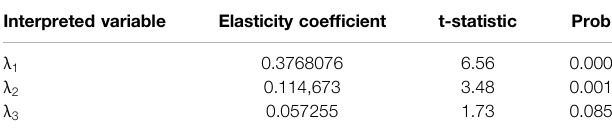
TABLE 6 | Results of the threshold effect